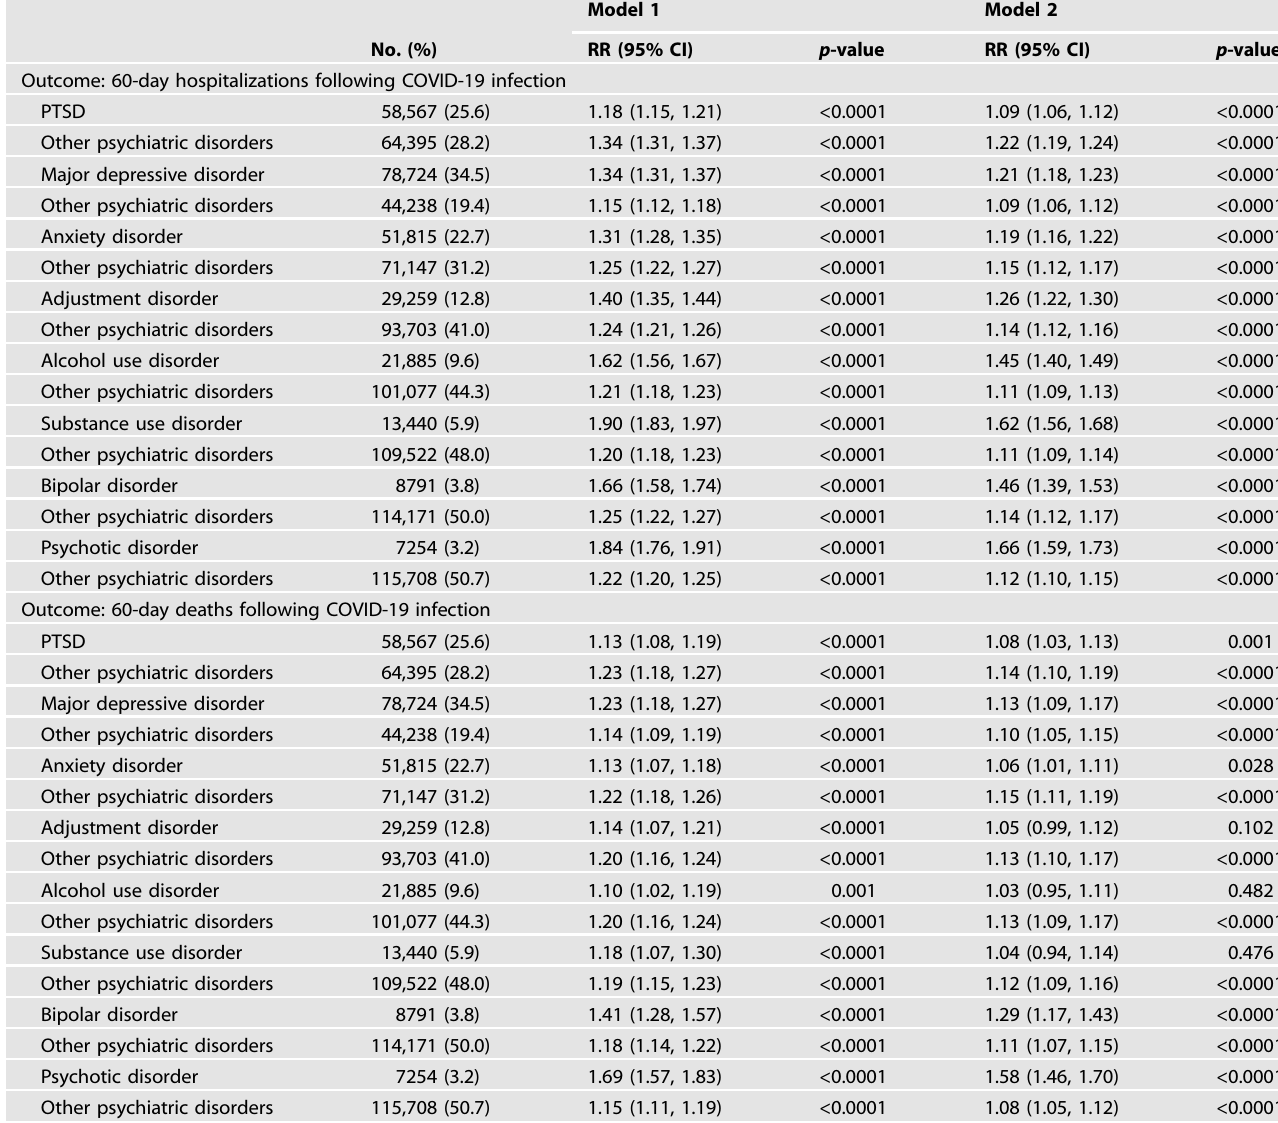
Table 4. Individual generalized linear models for associations between each psychiatric disorder with 60-day hospitalization and death following COVID-19 infection ( n =